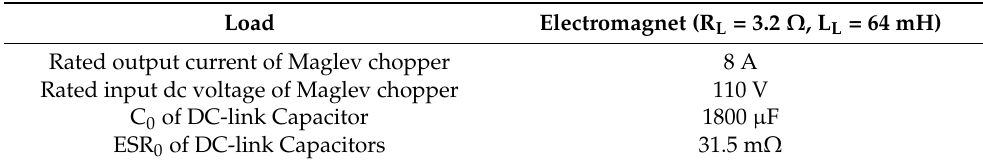
Table 1. Simulation Circuit Parameters for Data